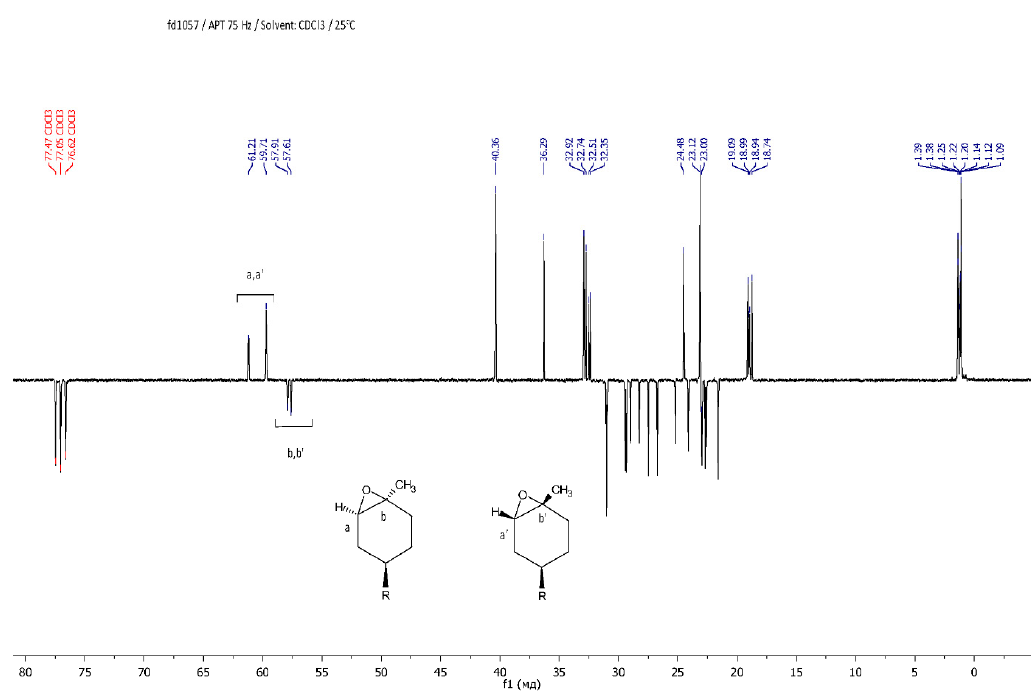
Figure 1. APT NMR spectrum of LimOx-G 0.5 TMS 2 .